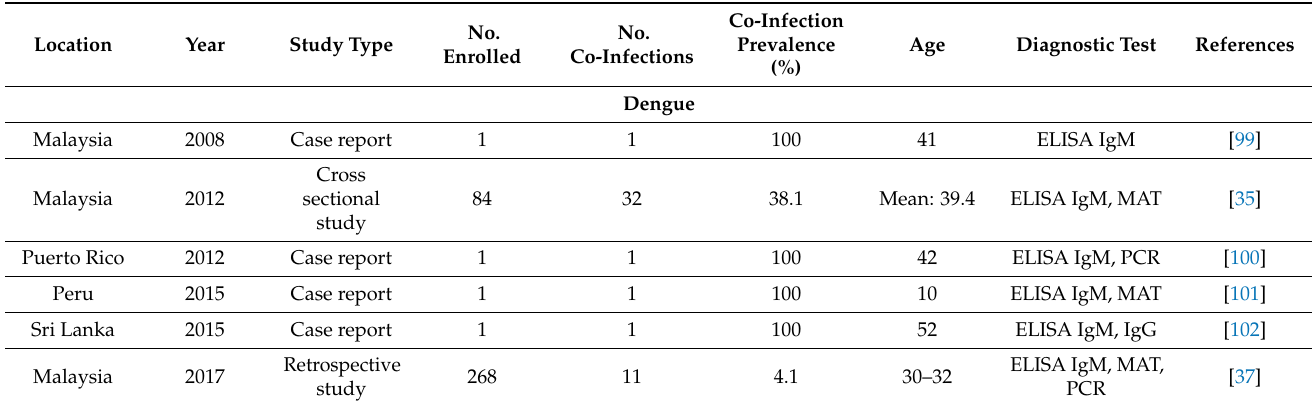
Table 2. Cases of leptopsira